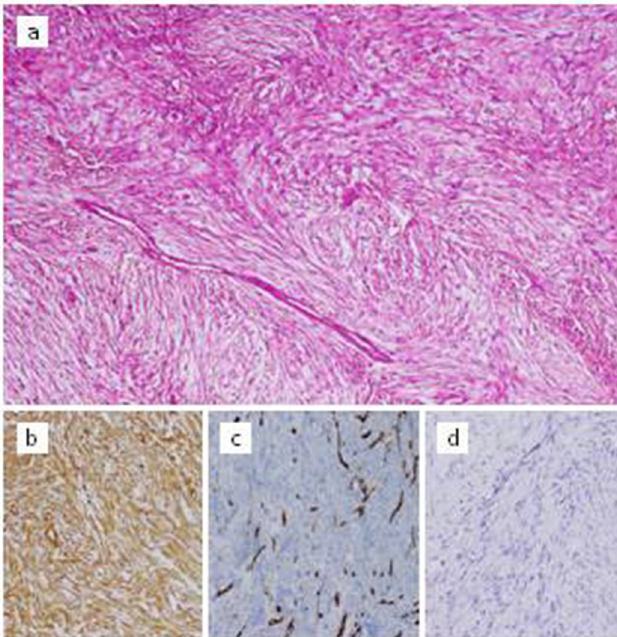
Fig. 2. Photomicrograph showing a) A collagenous stroma comprising of numerous proliferating spindle cells arranged in a biphasic pattern (H&E 4X), (b) Spindle cells showing cytoplasmic expression of smooth muscle actin (IHC-10X), c) CD 34 expression present in endothelial cells but absent in spindle cells (IHC-10X), d) Spindle-shaped cells lacking the expression of b -Catenin (IHC-10X).